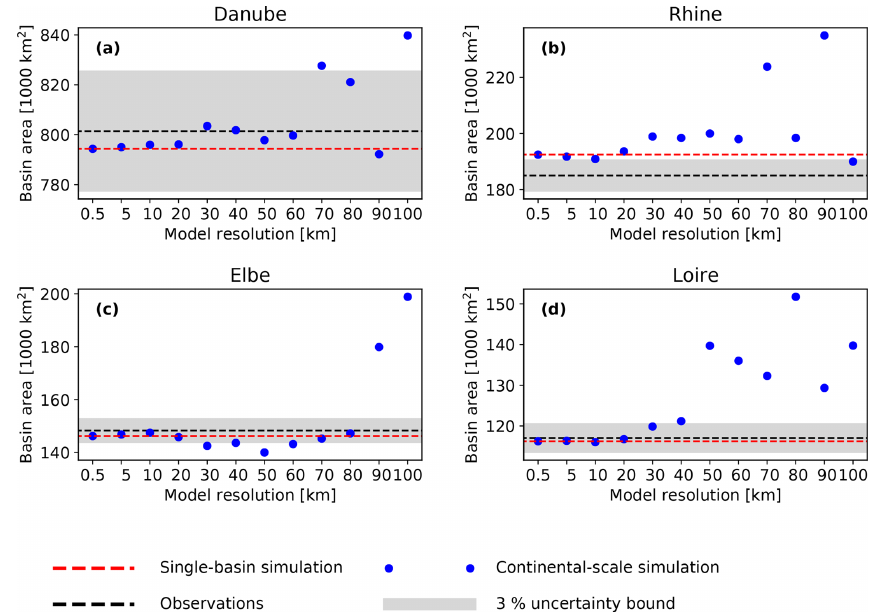
Figure C1. Basin areas for four major European river basins. Blue circles denote the calculated basin area derived by the D8 method at different resolutions for continental-scale simulation. The red dashed line shows the basin area for a single-basin setup. The black dashed line shows the true value with an uncertainty bound of 3%.